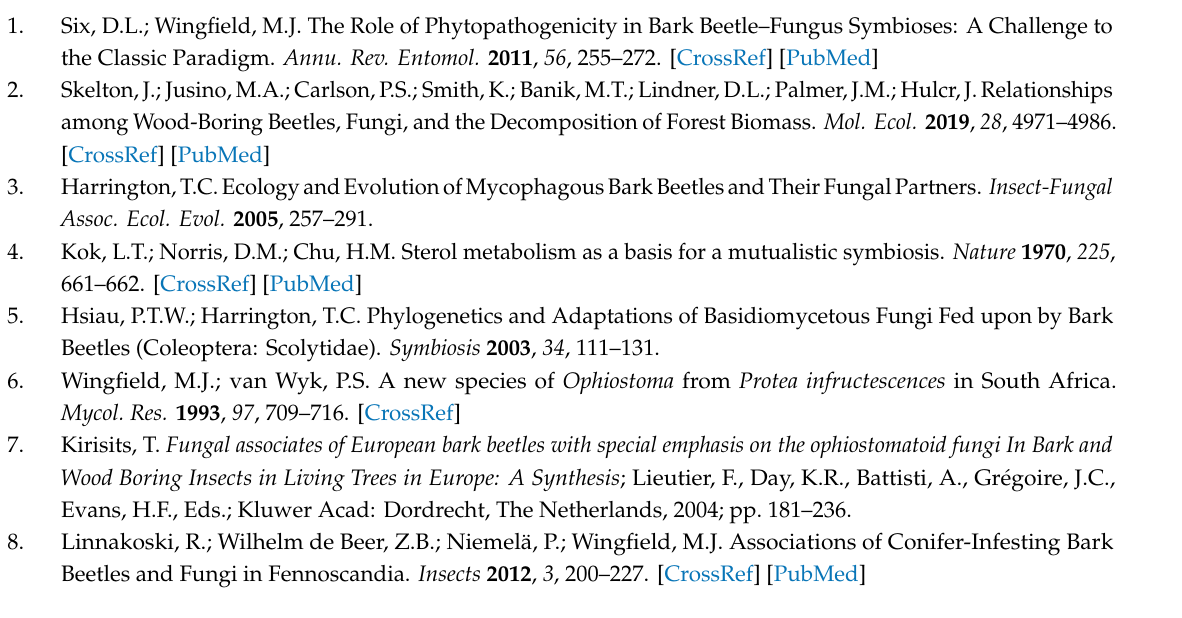
Table S1: Hosts and Scolytinae vectors species associated with strains from Geosmithia langdonii - Geosmithia sp. 32 and Geosmithia sp. 21- G. xerotolerans